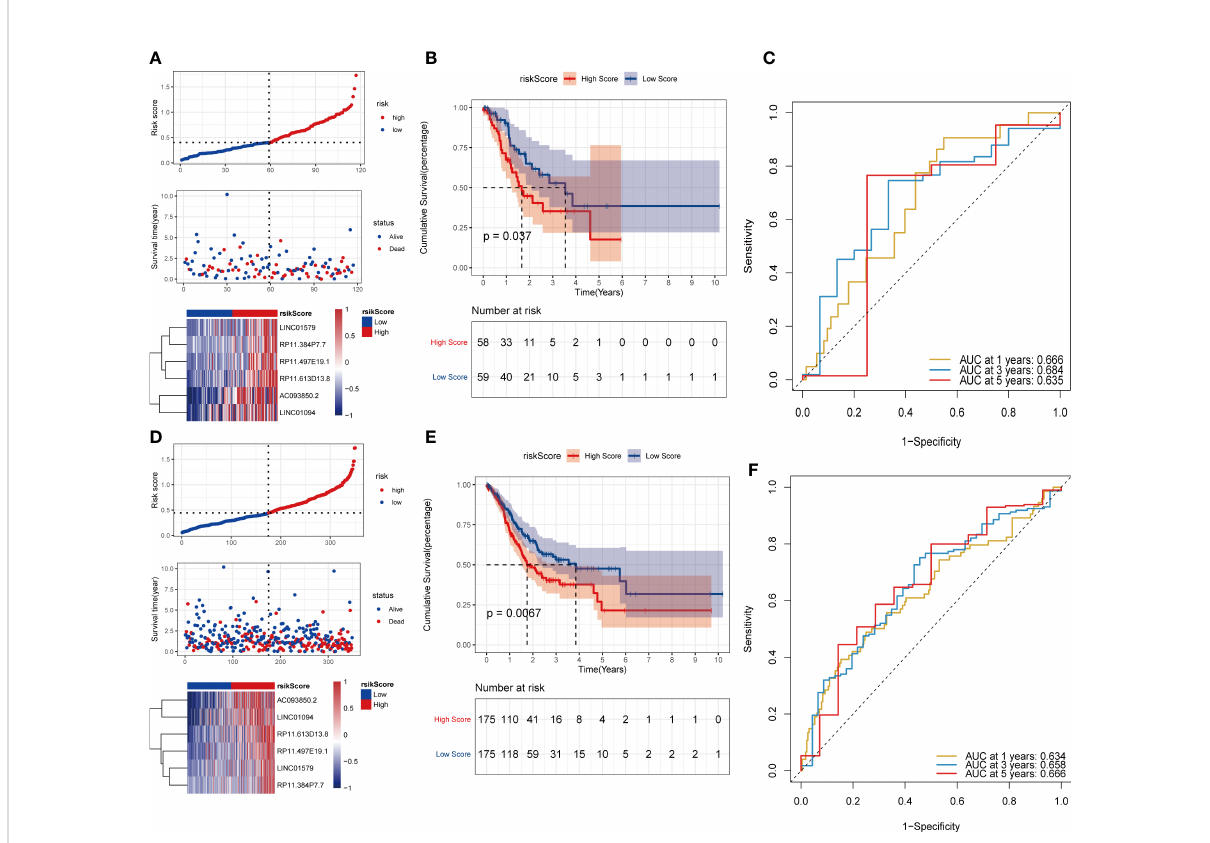
FIGURE 7 Validation of the risk model on the test set and the ensemble set. (A) Distribution map of test set risk scores; (B) Test set survival curve; (C) Test set 1, 3, and 5-year ROC curves; (D) Distribution map of overall set risk score; (E) Overall set survival curve; (F) Overall set 1, 3, 5-year ROC